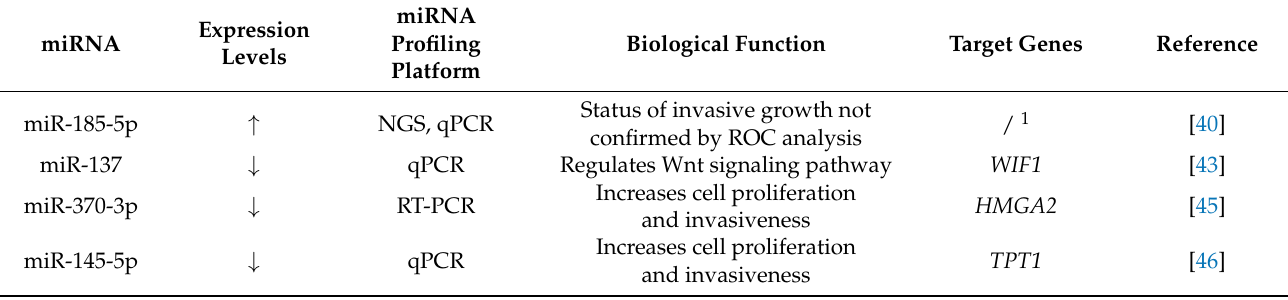
Table 1. Summary of differentially expressed miRNAs with their validated targets in non-functioning pituitary adenomas.